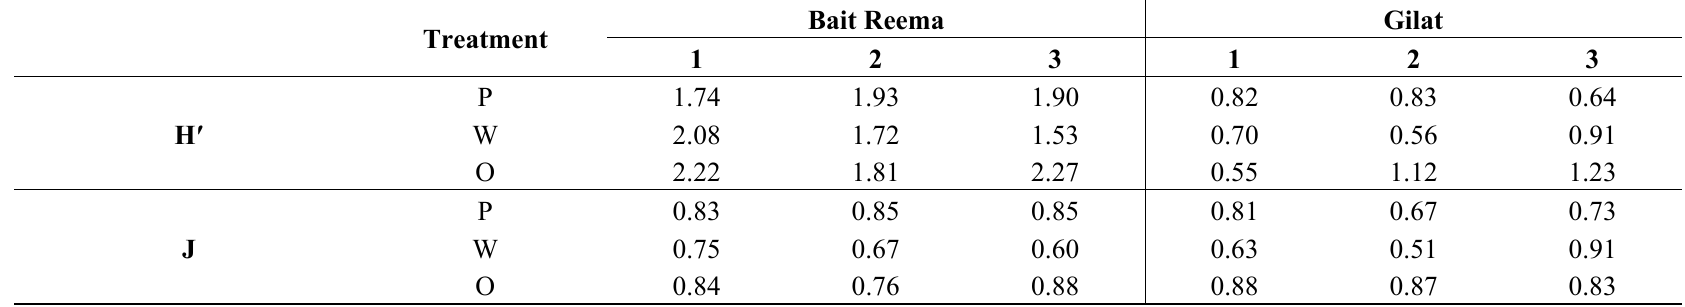
Table 4. Shannon-Wiener diversity index (H ′ ) and Pielou’s evenness (J) found in Bait Reema and Gilat pre application (P) and after application of OMW (O) or water (W) at the 1st, 2nd and 3rd sampling